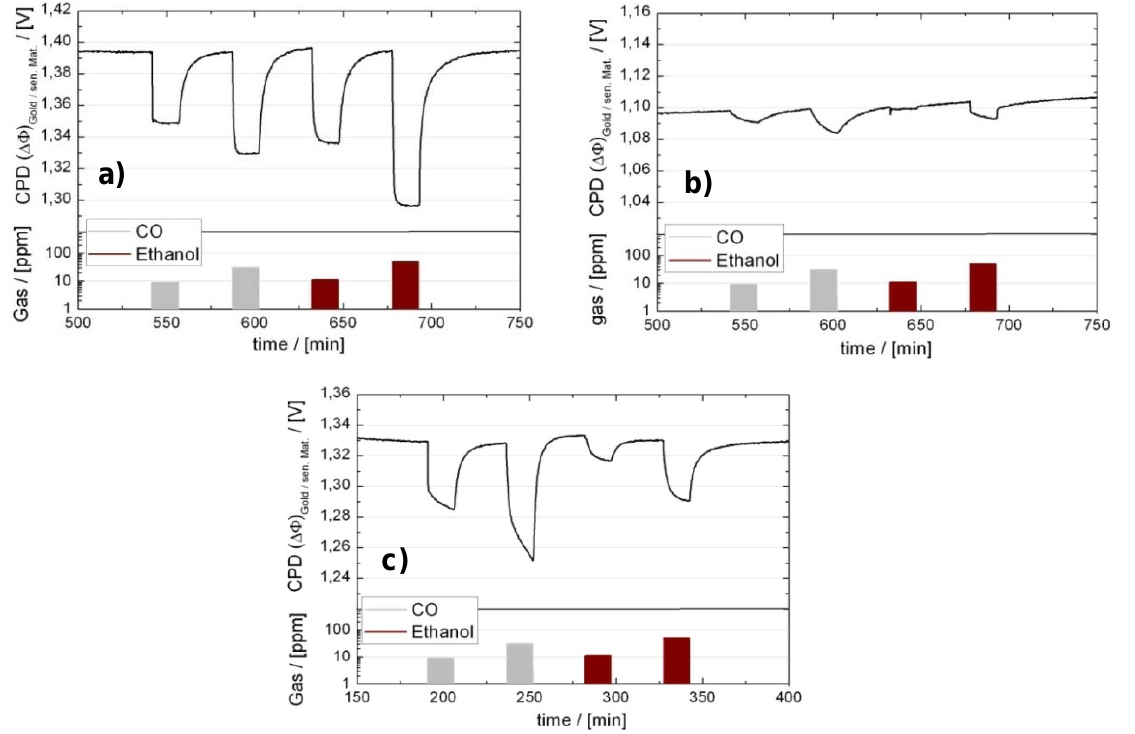
Figure 17. Work function change of the Ga 2 O 3 /Pt system to a reducing gas (CO) and ethanol at room temperature in wet synthetic air: (a) Immediately after preparation (last thermal budget 700 °C for 2 h to form nano-dispersed Pt. (b) After 800 h storage at room temperature. (c) After storage and thermal activation at 175 °C for 5 mins. The thermal activation worked repeatedly during all